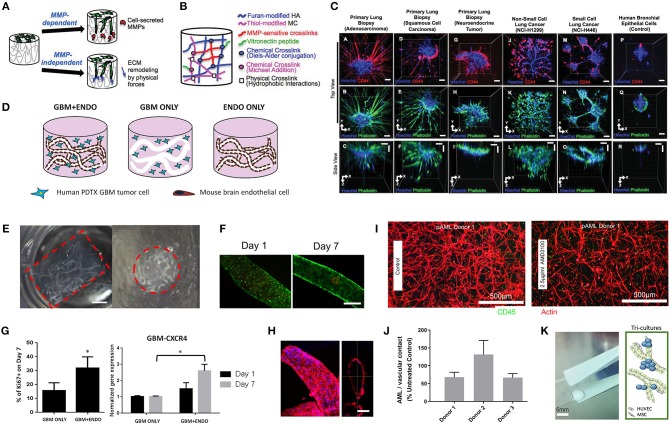
Hydrogel culture approaches. (A–C) Rationally designed 3D hydrogels model normal and malignant lung tissue. (A) Schematic of potential cell invasion mechanisms. (B) Schematic of the composition of biomimetic stimuli-responsive 3D hyaluronan (HA) hydrogels. (C) Lung cancer cells express CD44 and show varying invasiveness into 3D HA hydrogels. (A–I) Primary cells isolated and cultured from three separate lung carcinoma biopsies identified as (A–C) adenocarcinoma, (D–F) squamous cell carcinoma, and (G–I) neuroendocrine tumor. (J–L) Non-small cell lung cancer and (M–O) small cell lung cancer cells. (P–R) Healthy human bronchial epithelial control cells do not invade into 3D hydrogels. (A,D,G,J,M) Lung cancer cells express CD44, while (P) healthy bronchial epithelial cells do not. (D–H) Combination approach to mimicking glioblastoma using PDX derived cell lines. (D) Schematic of hydrogel/microfiber structure and cellular combinations. (E) Cross-sectional views of encapsulated alginate microfibers in 3D hydrogels. Left = side view. Right = top view. Red = hydrogel edge. Scale bar = 2 mm. (F) Live (green) and dead (red) staining of endothelial cells after 7 days in cultures. (G) Co-culture with mouse endothelial cells increased glioblastoma proliferation via Ki67 staining (n = 150) (left), and increased expression of CXCR4 in glioblastoma tumor cells (right). *p < 0.05. (H) Confocal image demonstrating CD31 expression from HUVECs within alginate microfibres. (I–K) 3D culture of acute myeloid leukemia using starPEG-heparin hydrogels. (I) AML cells from a patient with AML untreated (left) or treated with 2.5 μg/mL AMD3100 (right), co-cultured with HUVECs and MSCs. (J) Percentage of AML contact with HUVECs and MSCs decreased after AMD3100 treatment in two out of three donors, compared with the untreated control sample. Means ± SD (variability within experiment, n = 1). (K) A biohybrid starPEG-heparin hydrogel for the culture of AML mono-cultures and tri-cultures with HUVECs and bone marrow-derived MSCs. Scale bar = 5 mm. (A–K) reproduced with permission from Tam et al. (2018), Wang et al. (2019), and Bray et al. (2017), respectively.